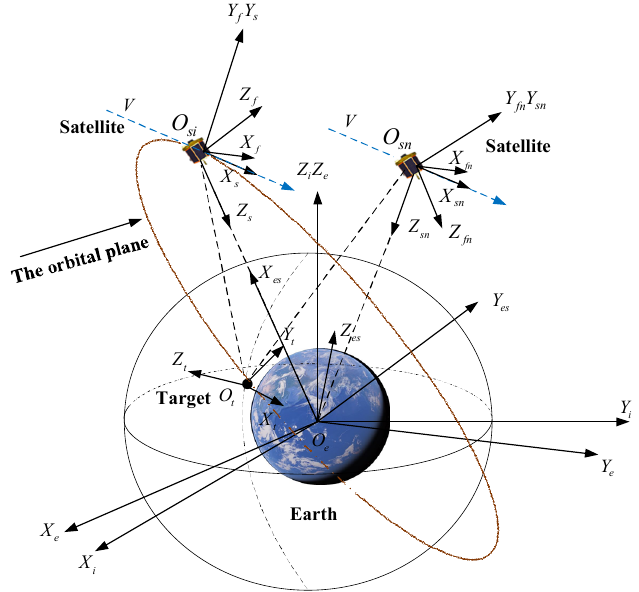
Figure 1. Coordinate systems.